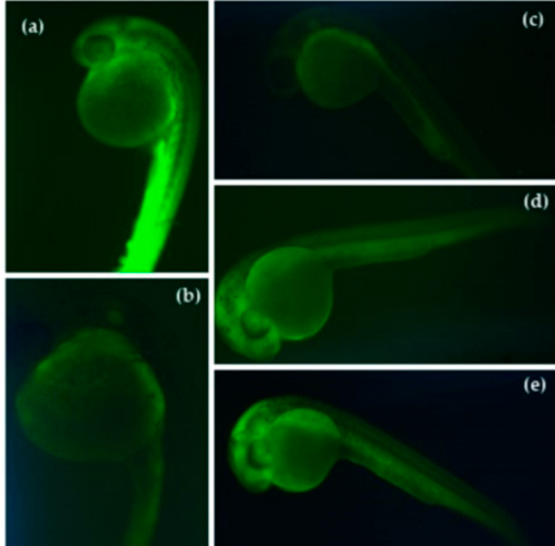
Figure 8. Effects of duodenal digest from germinated QPI for 72 h (G3) against 2,2 ′ -azobis (2-methylpropionamide)-dihydrochloride (AAPH)-induced oxidative stress (ROS) in the zebrafish embryo model. ( a ) AAPH treated group. ( b ) Non-treated group. ( c ) Duodenal digest of white QPI-G3. ( d ) Duodenal digest of red QPI-G3. ( e ) Duodenal digest of black QPI-G3.